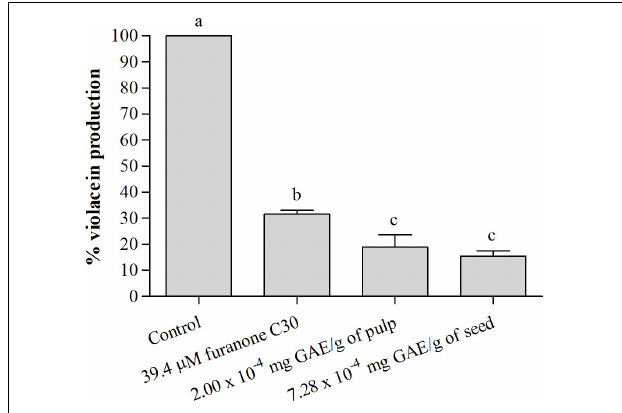
11.29 mg GAE/g of seed (dilutions ranging from 1:2 to